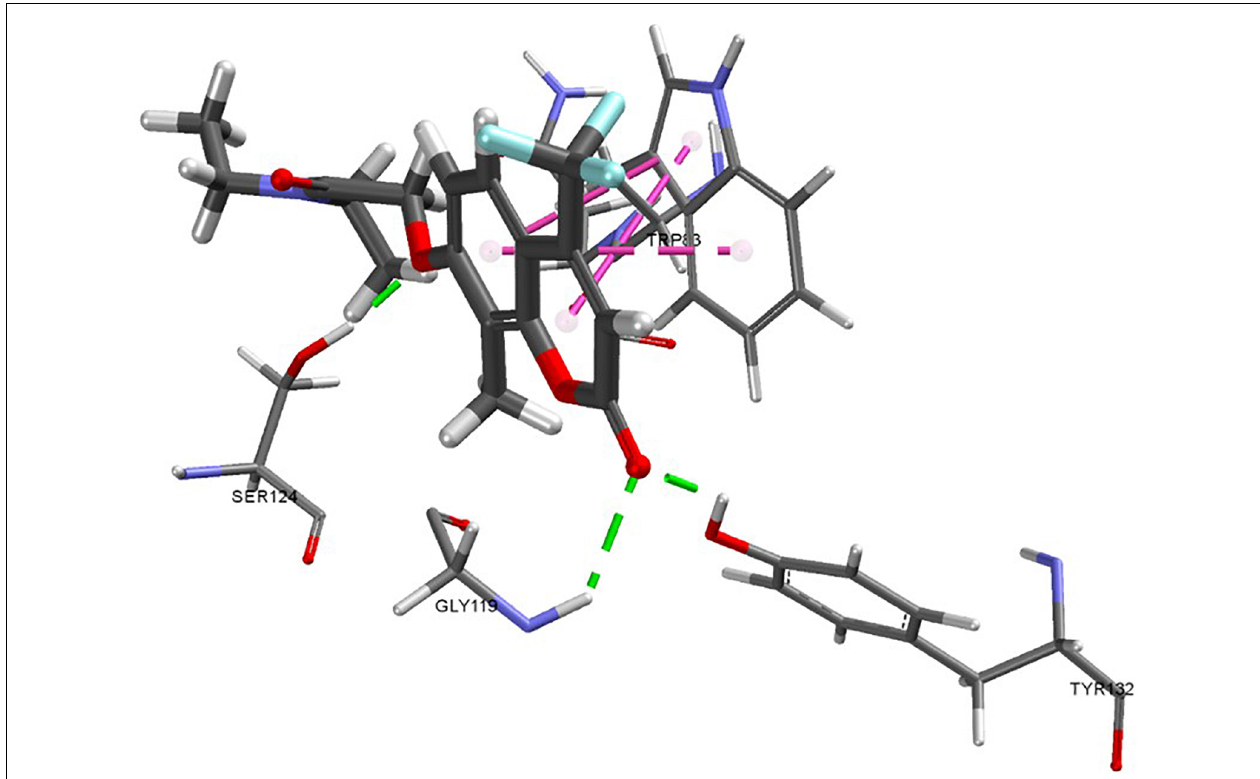
FIGURE 6 | Predicted docking pose of compound 20e . Green dashes indicate hydrogen bonding interactions and pink dashes indicate π - π interactions.